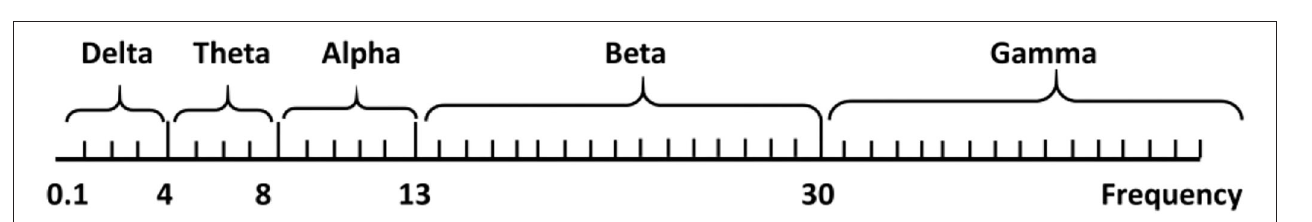
FIGURE 4 | Distribution map of EEG rhythm frequency